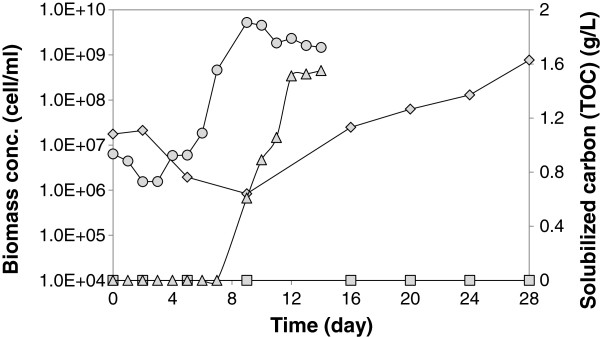
The total solubilized carbon and biomass profiles in theC. cellulolyticummono-culture experiments. The biomass profile in the mono-culture at pH of 7.2 (circle), TOC profile in the mono-culture at pH of 7.2 (triangle), biomass profile in the mono-culture under pH profile (rhombus), and TOC profile in the mono-culture under pH profile (square).